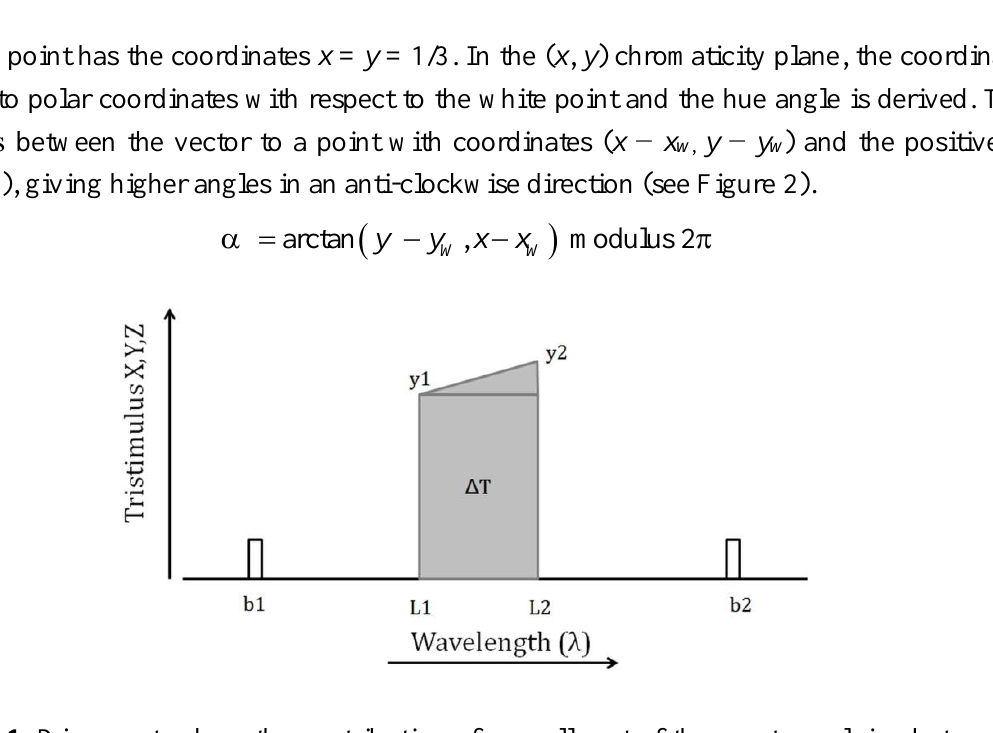
Figure 1. Diagram to show the contribution of a small part of the spectrum, lying between bands b1 and b2, to the tristimulus values (ΔT).